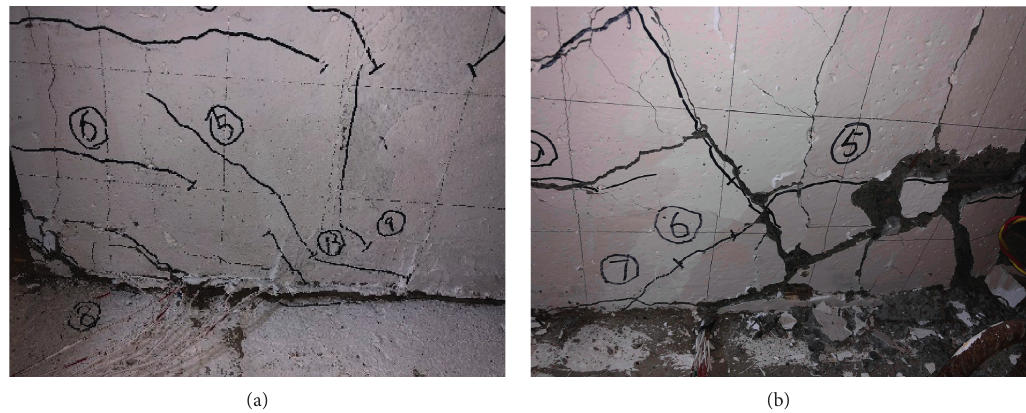
Figure 8: Typical damage of specimens. (a) Gap opening. (b) Concrete